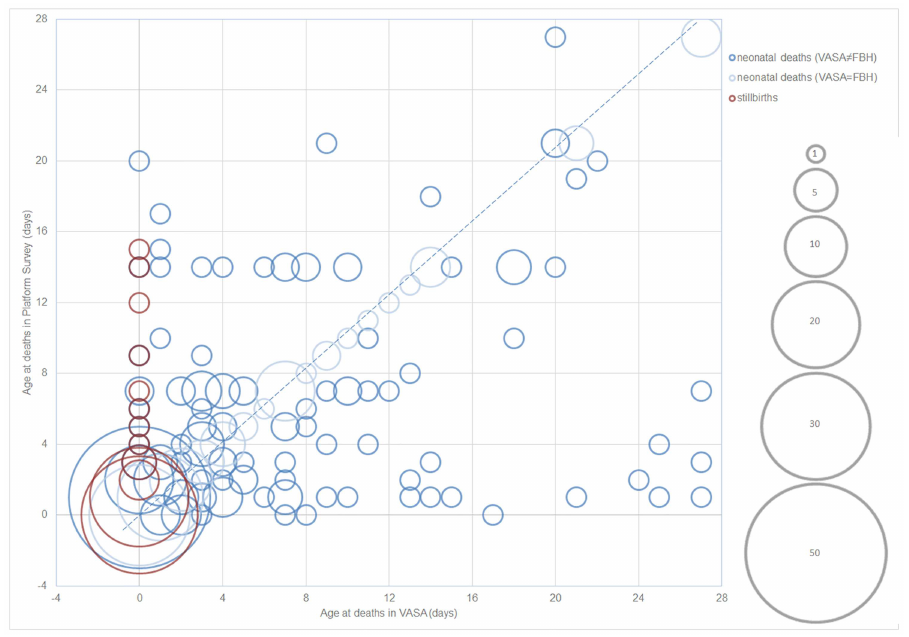
Fig 1. Age at deaths among neonates by survey type, Malawi, 2011–2012 * . * Sizeof the bubbles represents number of deaths, and red bubblesrepresent cases that were classifiedas stillbirths in VASA but neonatal deaths in